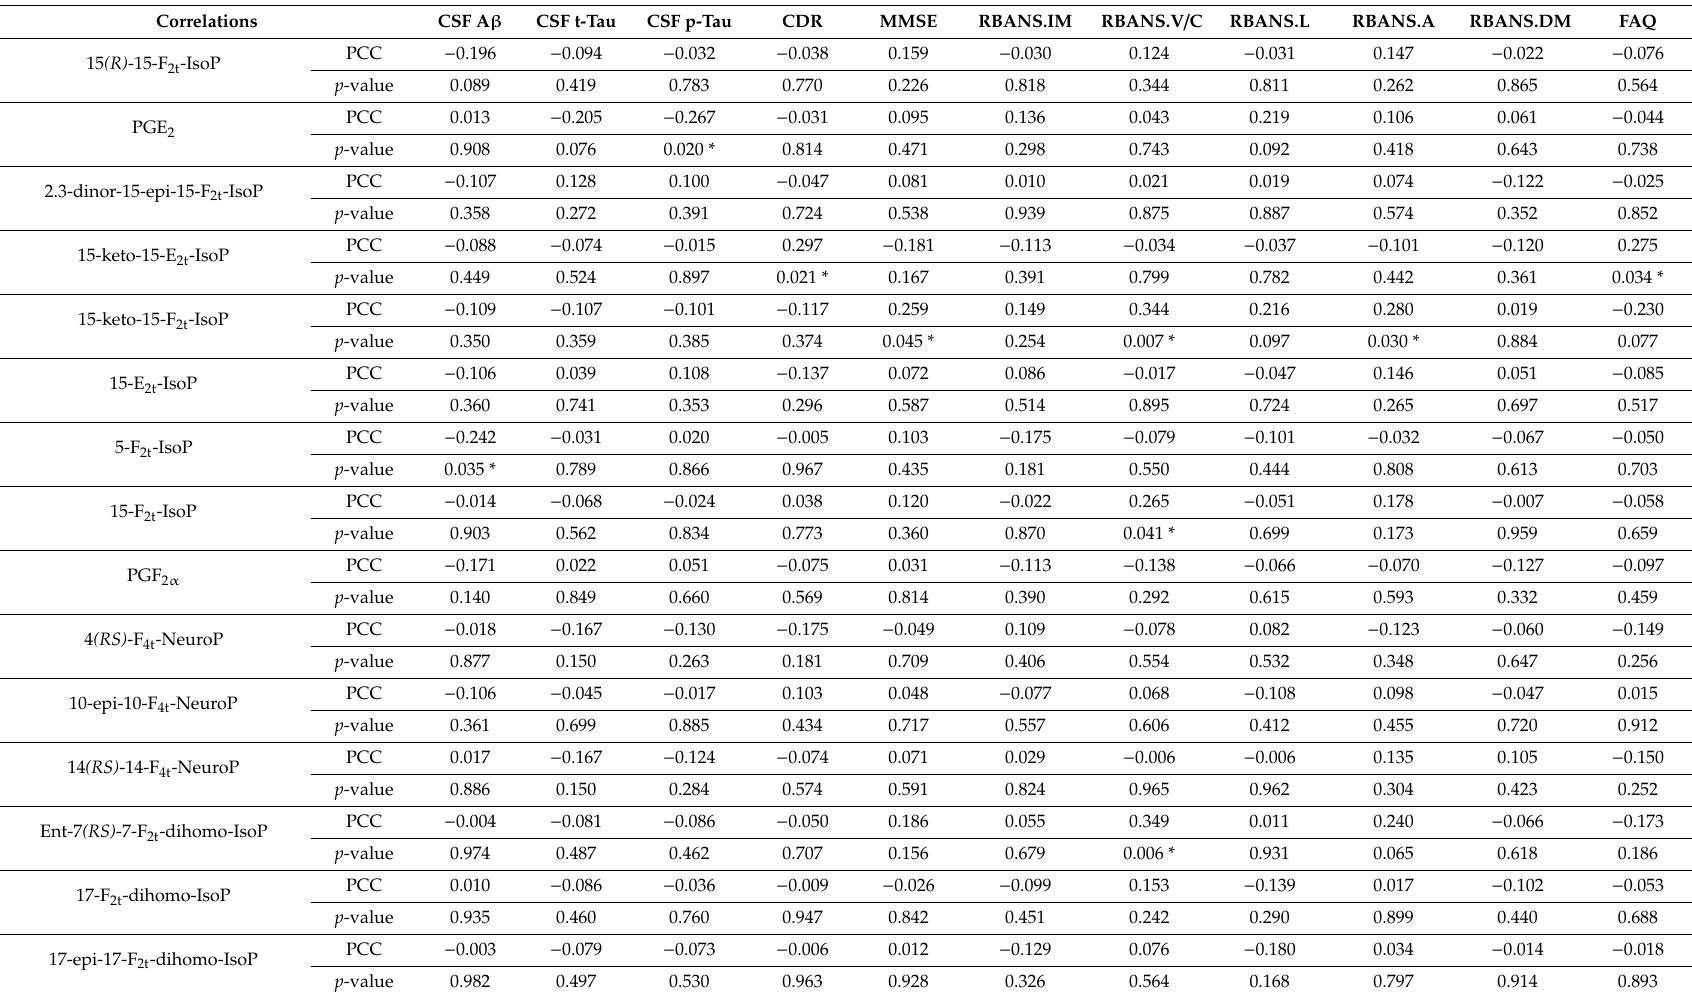
Table 2. Correlations between CSF isoprostanoids and clinical variables (standard CSF biomarkers, neuropsychological